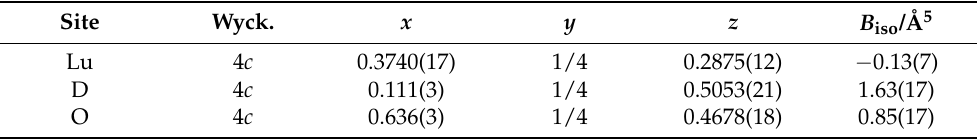
Table 5. The crystal structure parameters of orthorhombic LuDO based on neutron diffraction data at ambient temperature 5